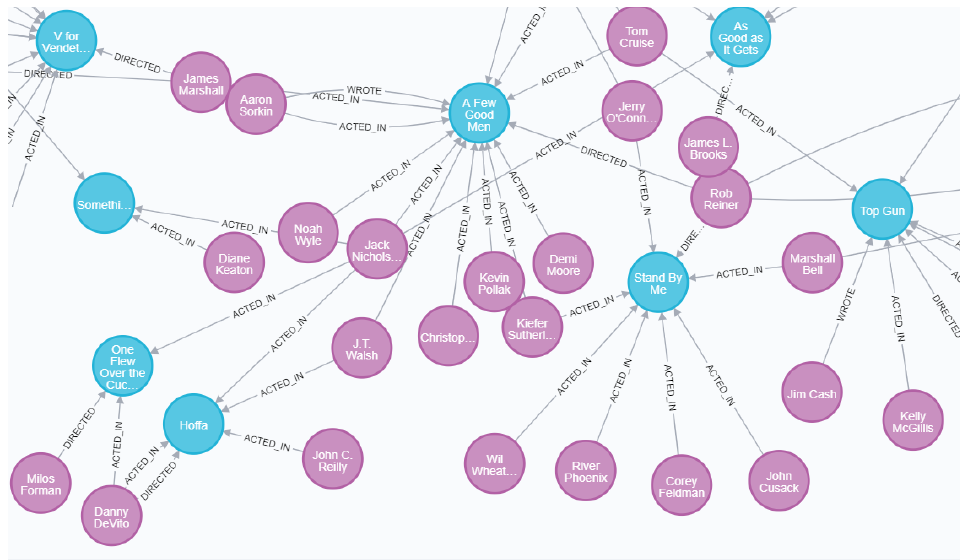
Figure 3. Partial display of knowledge